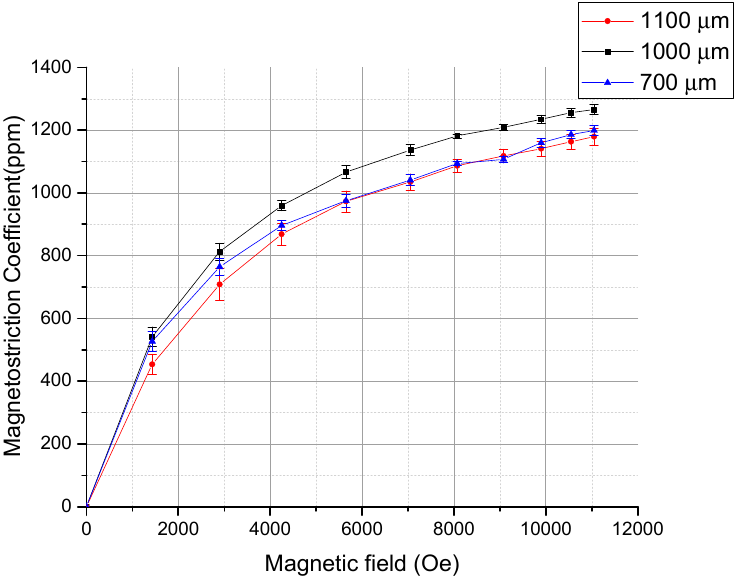
Figure 10. Magnetostriction coefficients of the Tb 0.36 Dy 0.64 Fe 1.9 film obtained from three cantilevers with lengths 700, 1000, 1100 µm.